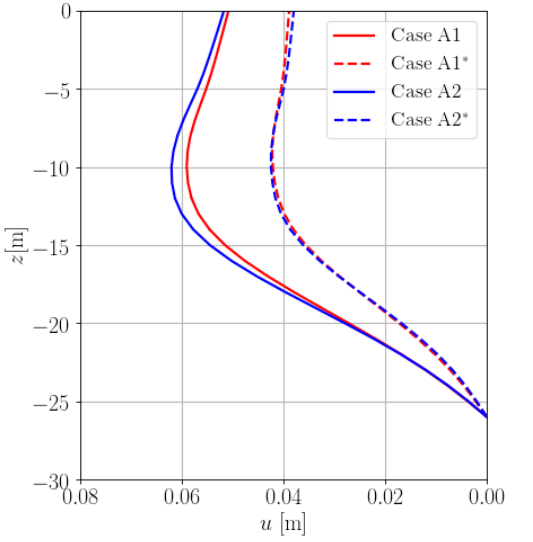
Figure 7: Comparison of wall deflections (Cases A1 and A2) at the time instance corresponding to the last excavation step (dashed lines) and at the time instance when the foundation raft is installed (solid